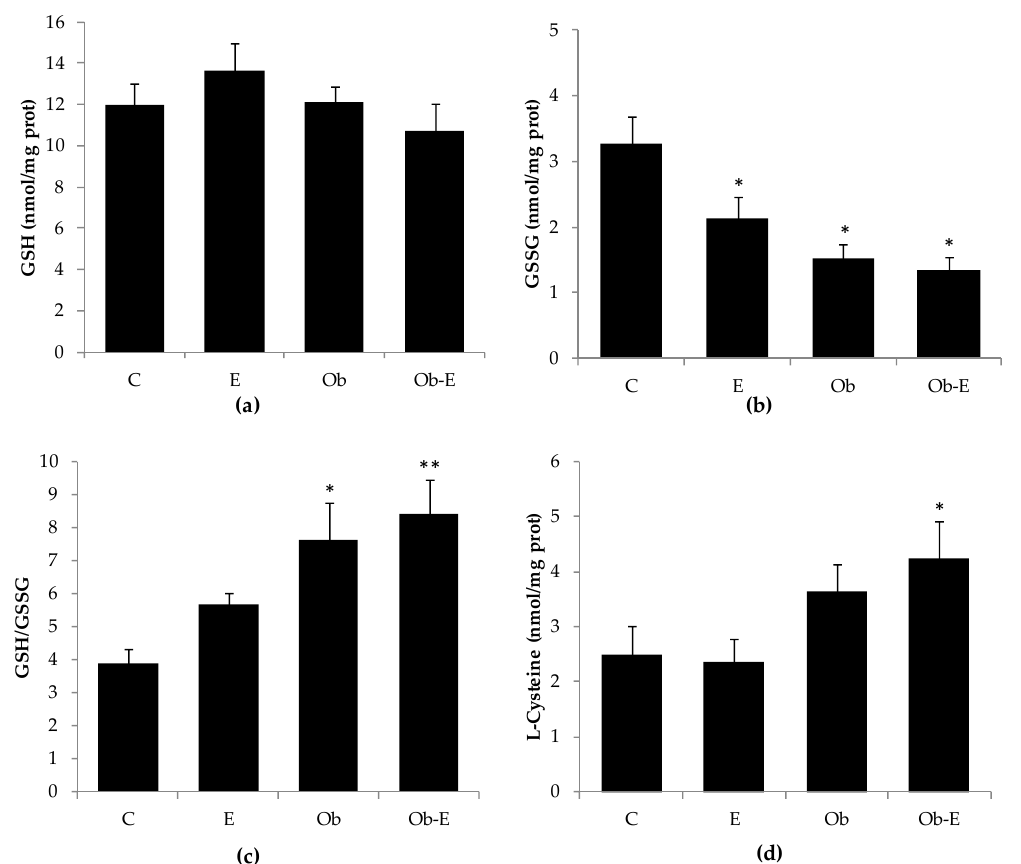
Figure 4. Effect of chronic ethanol exposure on brain glutathione (GSH) concentrations ( a ), glutathione disulfide (GSSG) concentrations ( b ) (* p < 0.05 vs. C), GSH/GSSG ratio ( c ) (* p < 0.05 vs. C, ** p < 0.05 vs. C and E), and L-cysteine values ( d ) (* p < 0.05 vs. C and E). Bars represent the mean ± SEM. C, wild-type control; E, wild-type ethanol; Ob, Ob control; Ob-E, Ob–ethanol.